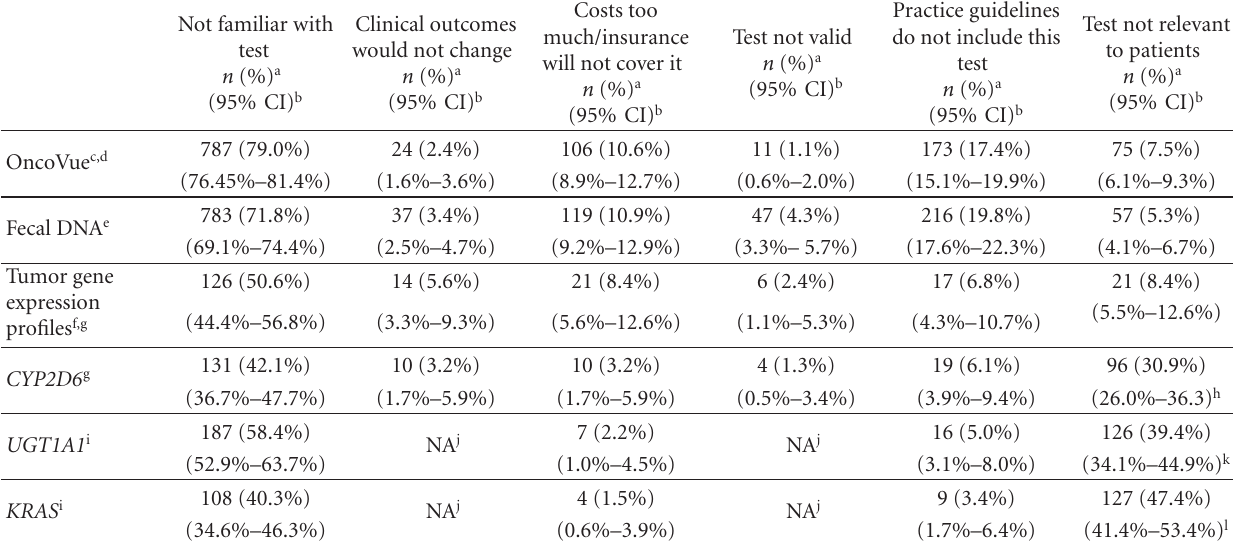
Table 4: Reasons why clinicians did not order or recommend various cancer genomic tests among clinicians who do not order that specific test.